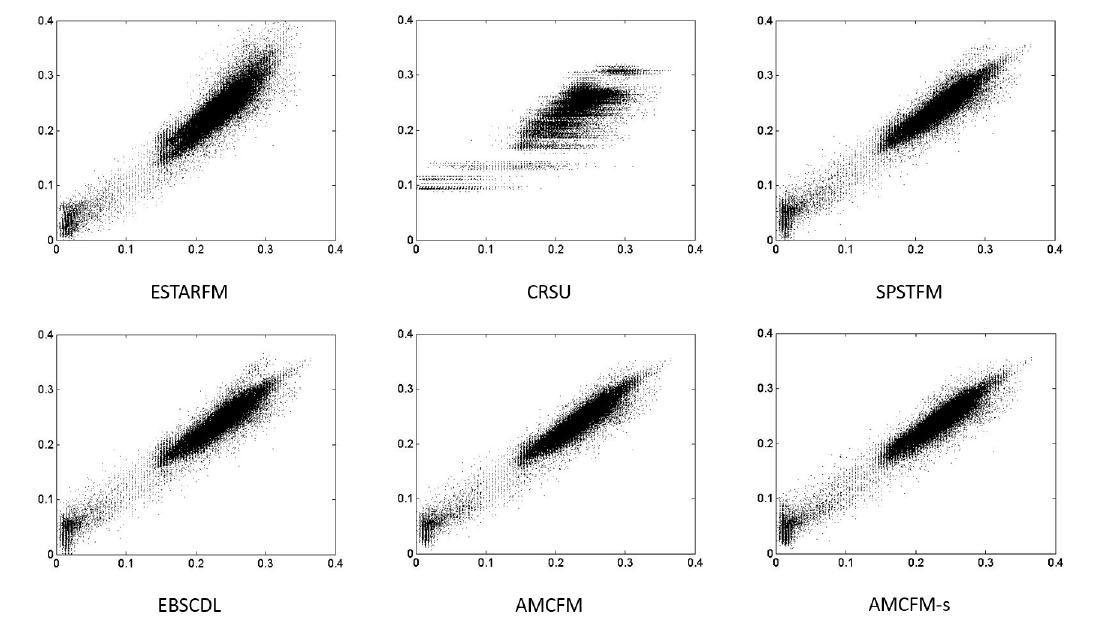
Figure 4. Scatter plots of NIR band of image 1. Abscissa is the true reflectance and ordinate is the predicted reflectance.